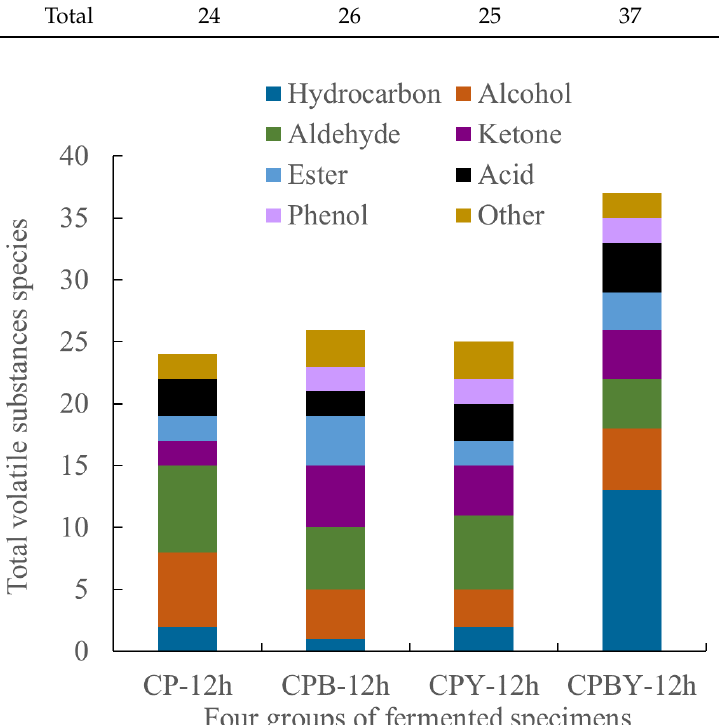
Figure 7. Comparison of volatile odor substances in four groups of fermented specimens. CP-12 h, fermented chickpea milk; CPB-12 h, fermented chickpea milk with papain treatment; CPY-12 h, fermented chickpea milk with yam addition; CPBY-12 h, fermented chickpea milk with papain treatment plus yam addition.